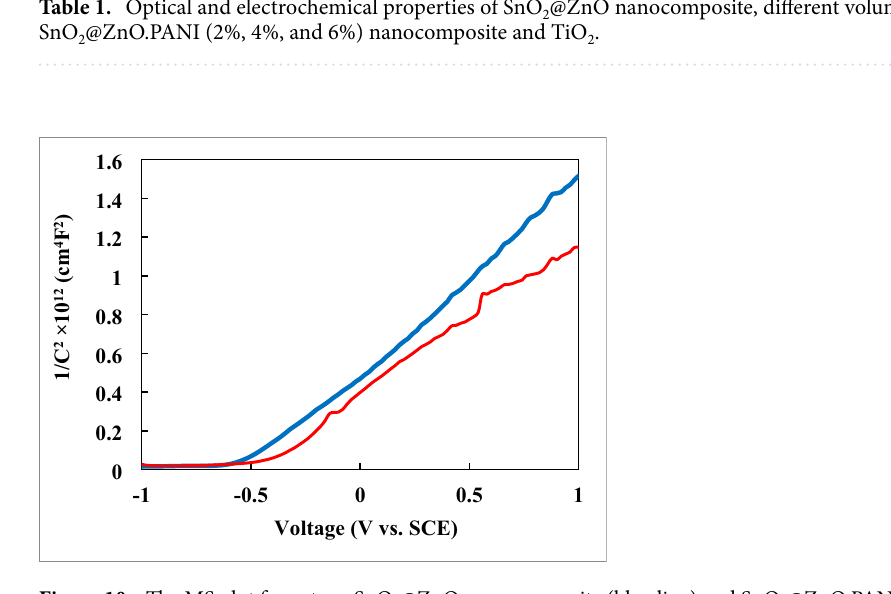
Figure 10. The MS plot for n-type SnO 2 @ZnO nanocomposite (blue line) and SnO 2 @ZnO.PANI 4% nanocomposite (red line) (electrolyte: Na 2 SO 4 0.5 M, Frequency: 1